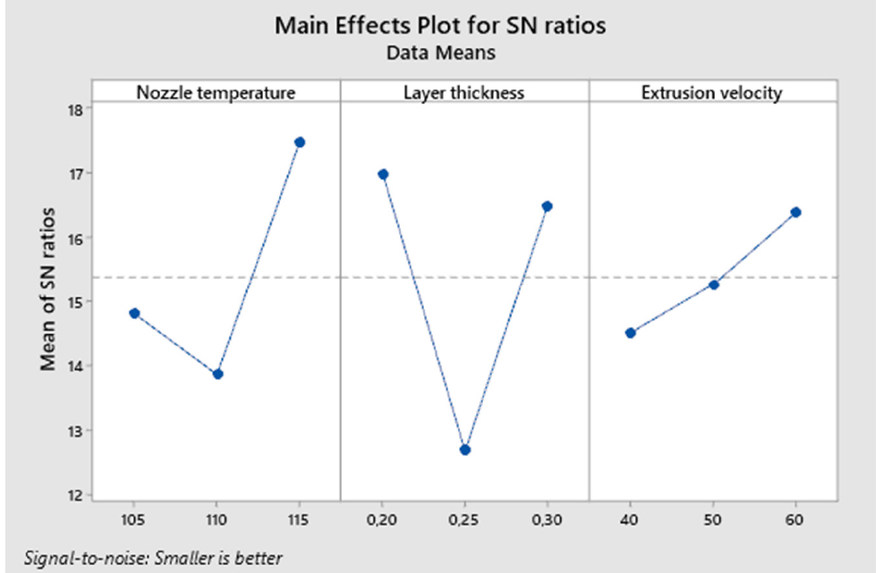
Figure 1. Main effects plot for S/N regarding part’s height accuracy.